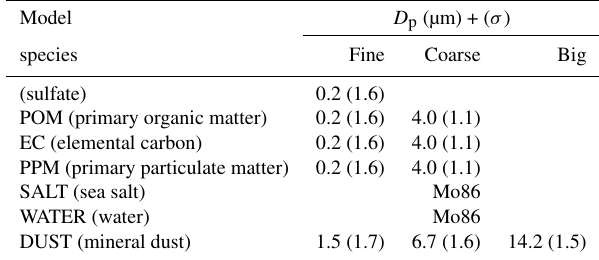
Table 4. Aerosols emissions with the three modes describing their size distribution: fine, coarse and big. The mean mass median diam- eter (MMMD) D p is expressed in µm; σ is unitless. “Mo86” refers to the parameterization of Monahan